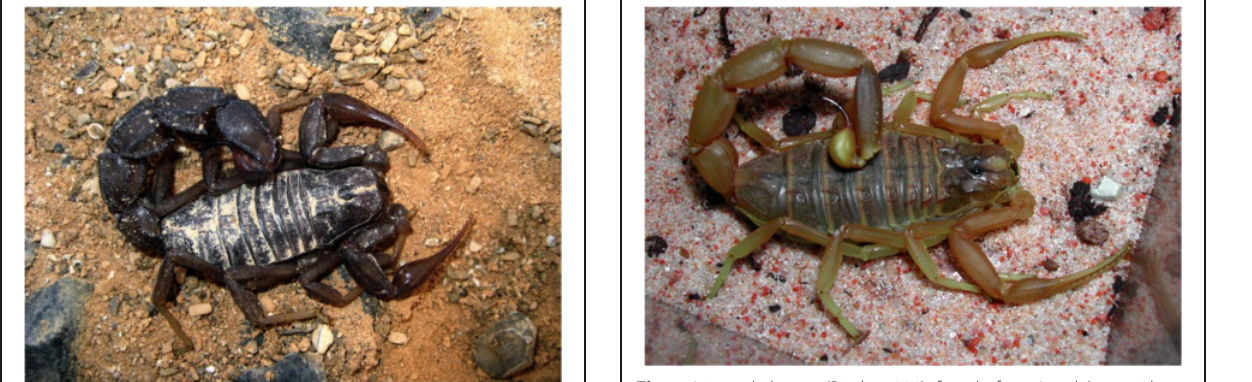
Fig. 7 Leiurus hebraeus (Birula, 1908); female from Israel (copyright by Eric Ythier, reproduced with permission)